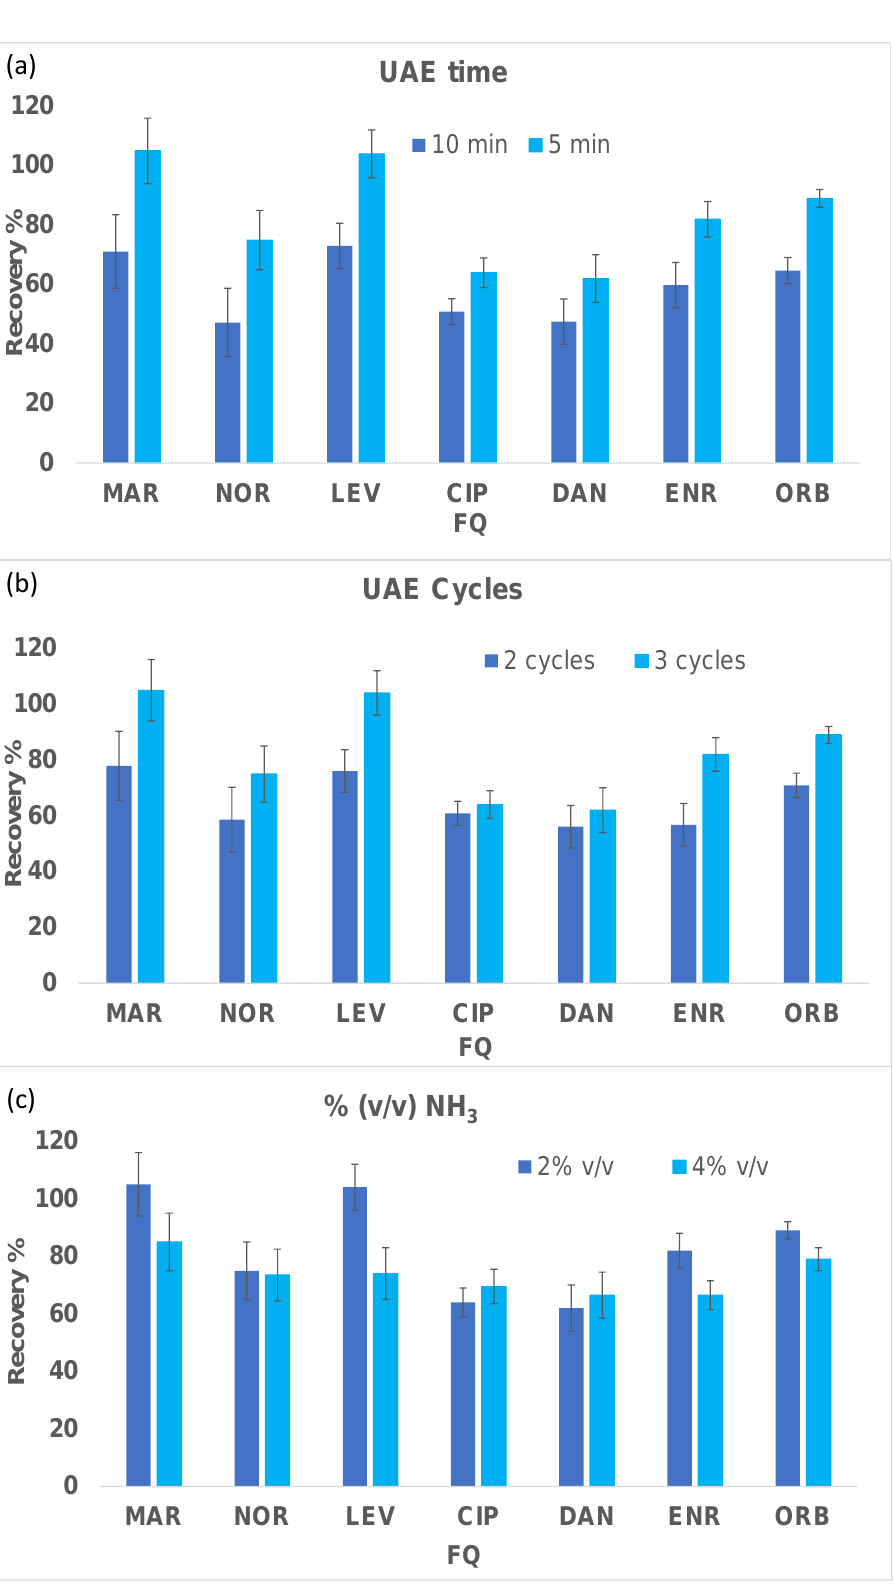
Figure 1. ( a ) Influence of time per UAE cycle on extraction efficiency (% R, n = 3) from freeze-dried spinach. ( b ) Influence of number of UAE cycle on extraction efficiency (% R, n = 3) from freeze-dried spinach. ( c ) Influence of ammonia amount on extraction efficiency (% R, n = 3) from freeze-dried